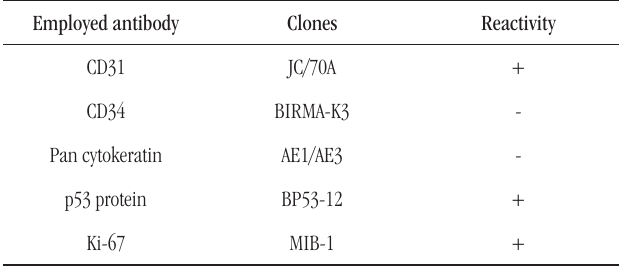
taBLE − Immunohistochemical study. Indirect immunoperoxidase method with DAB and heat- or protease-induced antigen